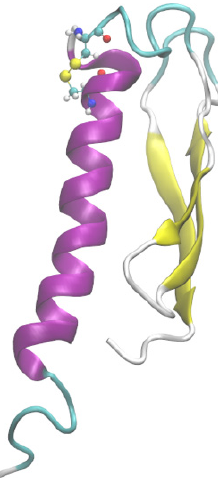
Figure 6. G1 modeling structure (Model3).